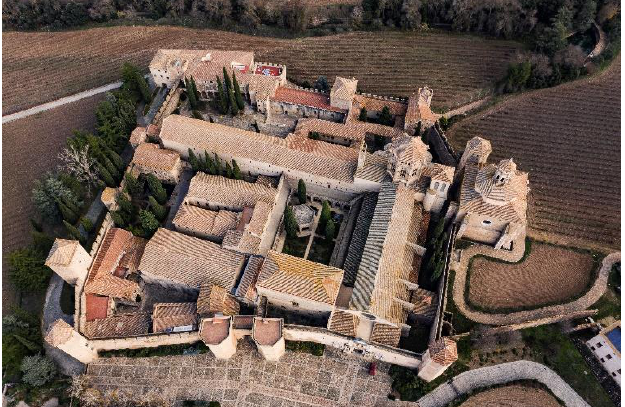
Figure 12. Church as the southern border.